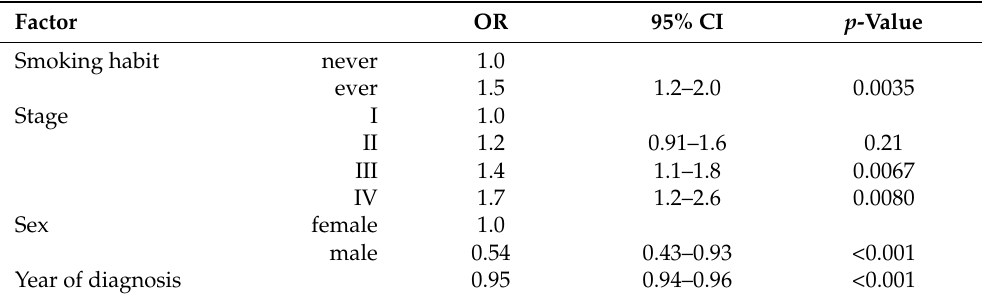
Table 3. Results of the logistic regression with age at diagnosis, smoking habit, pathological stage, sex, and year of diagnosis in the discovery series.